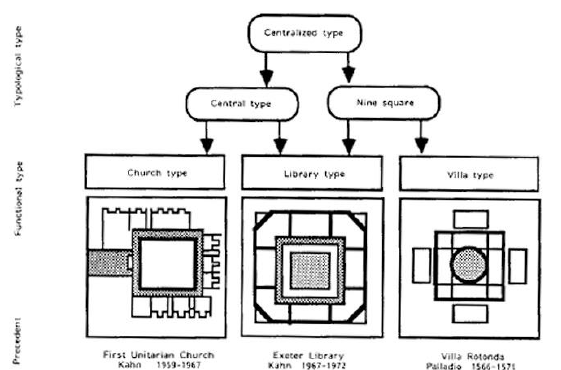
Figure 6. Precedents, functional types, high level typological concepts. (Oxman, 1990b, p. 23) People are believed to benefit from precedents by mining the information they contain through analysis and